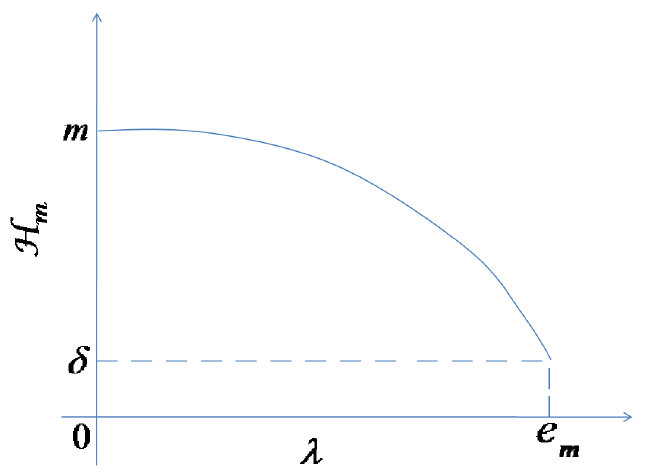
Figure 2. The decreasing positive function H m ( λ ) . The parameter L , defining the height of the detached exterior space ˜ D e selected equal to the value e m k